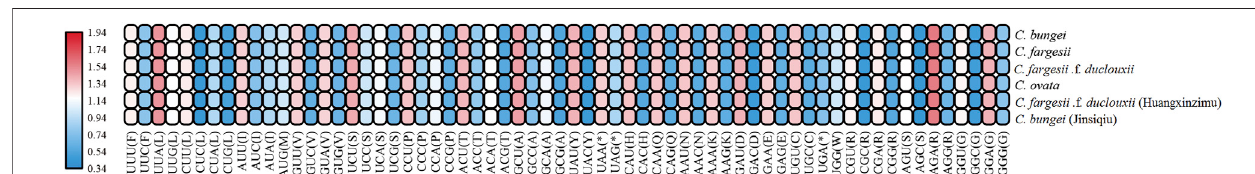
Frontiers in Genetics |